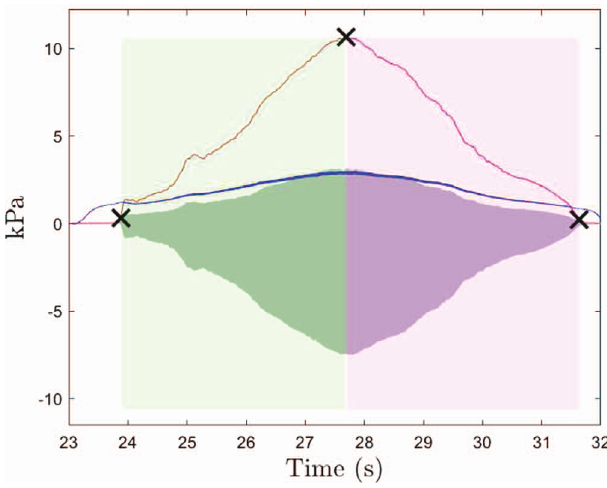
Figure 5. Crescendo-decrescendo maneuvers performed by the trumpet player. Mouthpiece pressure (gray), mouth pressure (blue) and peak-to-peak mouthpiece pressure envelope (red). The crosses indicate the onset, maximum amplitude and sound extinction locations. The green area corresponds to the crescendo phase, the magenta area to the decrescendo